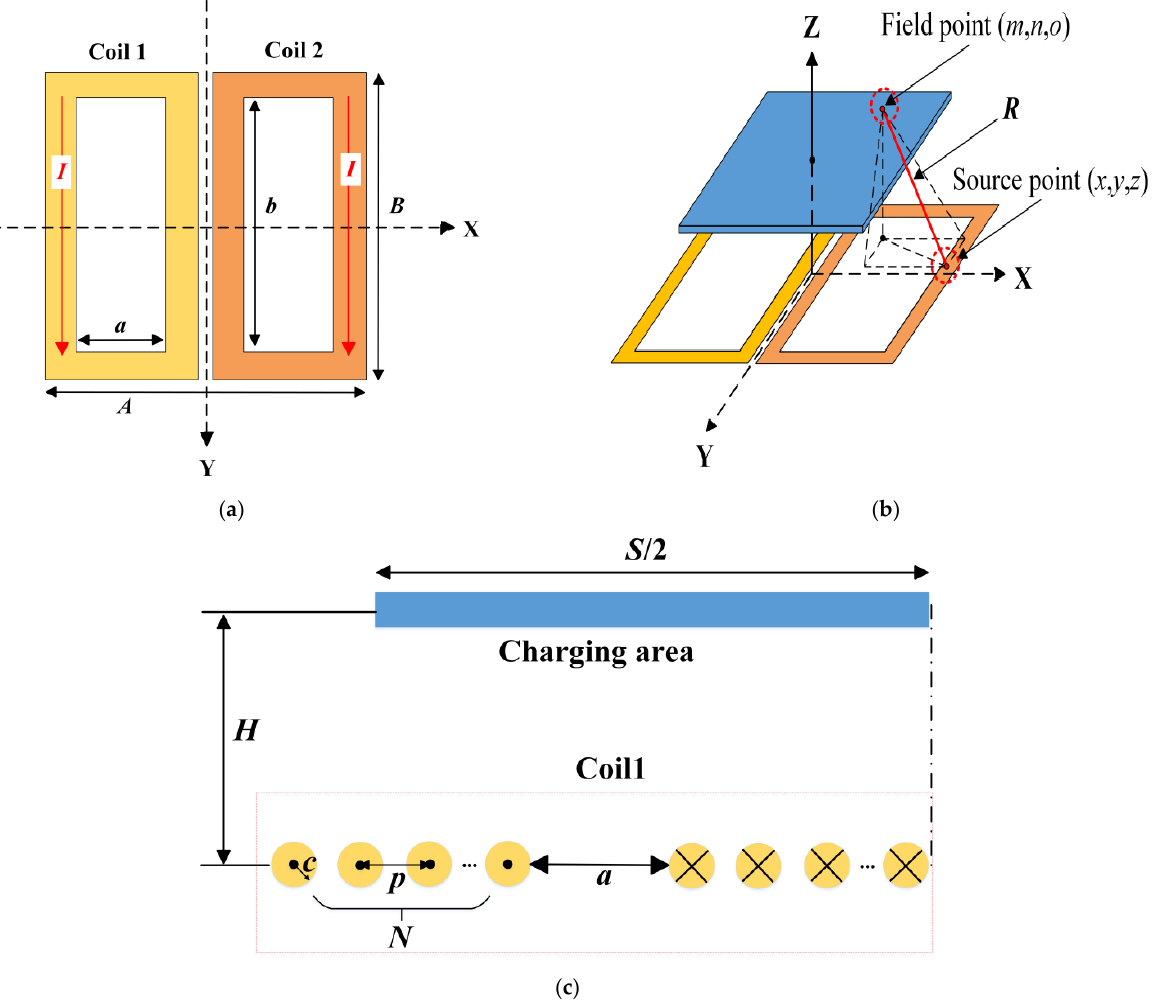
Figure 1. ( a ) Top view of a regular DD coil; ( b ) oblique view of a regular DD coil; ( c ) front view of a regular DD coil. Table 1. Parameters of the coil structure.